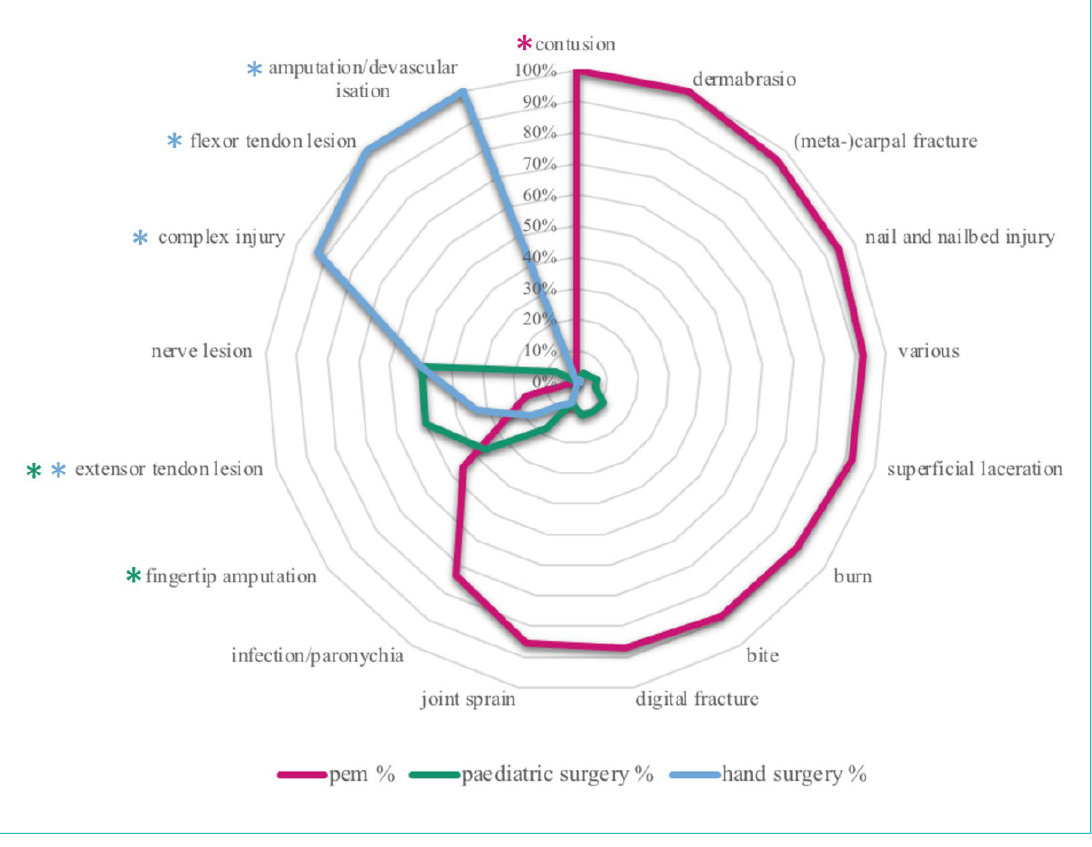
Figure 3: Distribution of injury patterns by treating discipline. * Higher than expected (p <0.001) (adjusted standardised residuals analysis with Bonferroni correction). For a clearer presentation of the data, only those injuries where the frequency of treatment was higher than expected were